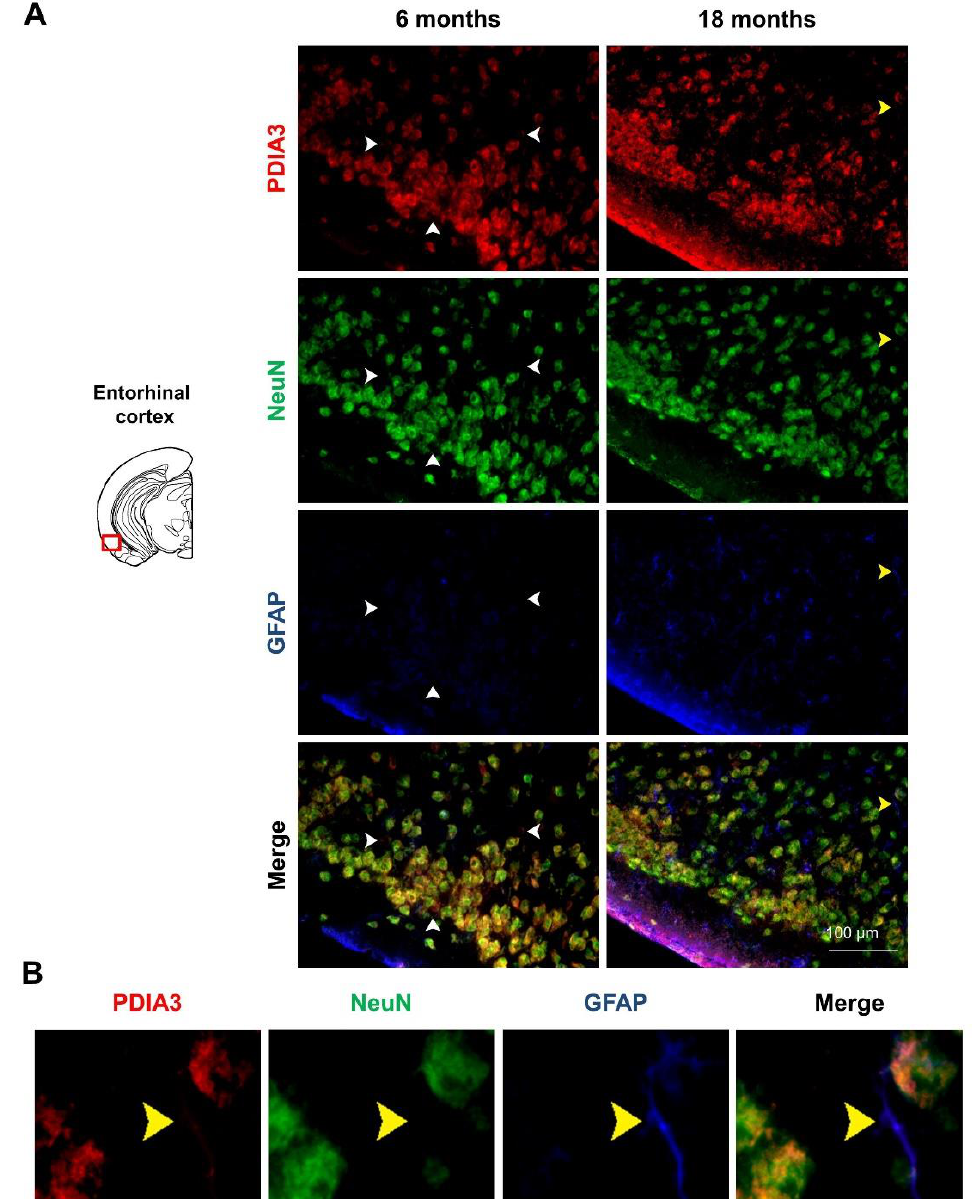
Figure 7. PDIA3-NeuN-GFAP protein levels observed in the entorhinal cortex of 3 × Tg-AD mice: ( A ) Representative microphotographs of PDIA3-NeuN-GFAP triple-fluorescent immunostaining (red, green, and blue, respectively) performed on brain slices of entorhinal cortex collected from 6- and 18-month-old 3 × Tg-AD mice. The white arrows indicate the PDIA3 single-positive cells while the yellow arrows indicate the PDIA3-GFAP co-localization. Original magnification: 20 × ; scale bar was set at 100 µ m; ( B ) Representative microphotographs of PDIA3-GFAP co-localization in astrocytes from entorhinal cortex of 18-month-old 3 × Tg-AD mice.